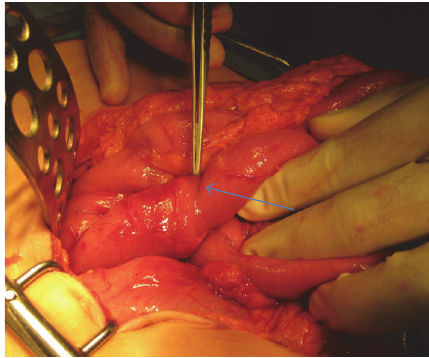
Figure 4: Superior mesenteric artery indentation on the third part of duodenum (blue arrow) (Case Report